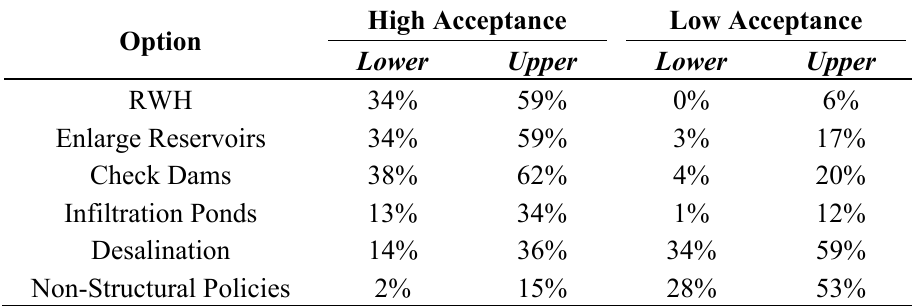
Table 3. One-sided 95% Clopper-Pearson confidence intervals for acceptance of